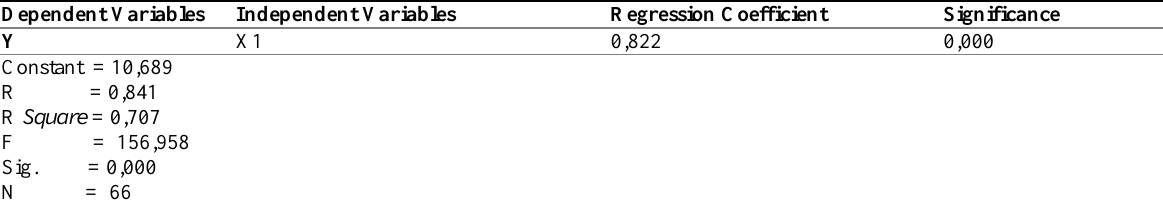
Table 2: Simple Regression Recapitulation